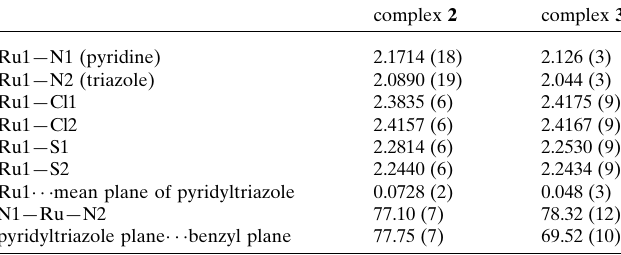
Table 1 Selected bond distances for complexes 2 and 3 , the distance between Ru and the mean plane of the pyridyltriazole (A˚ ), the N1—Ru—N2 angle, and the angle between the pyridyltriazole and benzyl mean planes ( (cid:2) ).